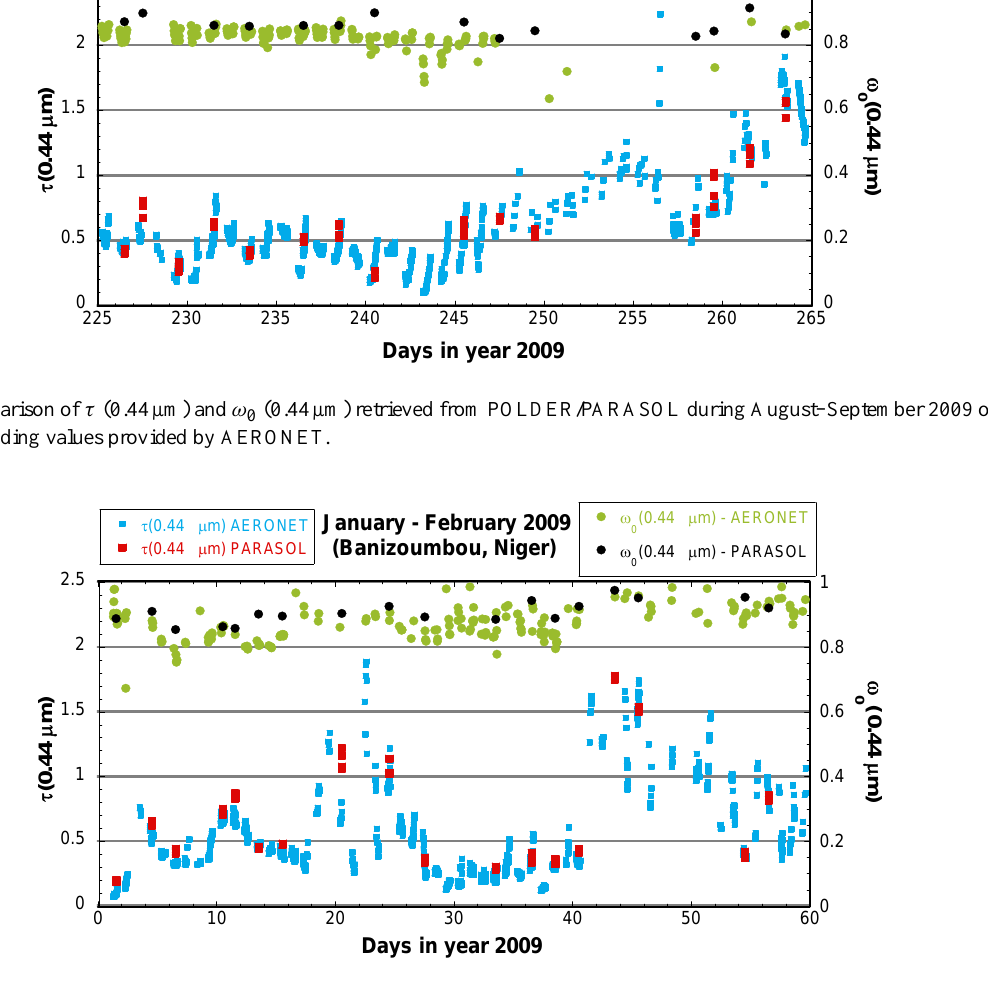
Fig. 21. The comparison of τ (0.44µm) and ω 0 (0.44µm) retrieved from POLDER/PARASOL during January–February 2009 over Bani- zoumbou with the corresponding values provided by